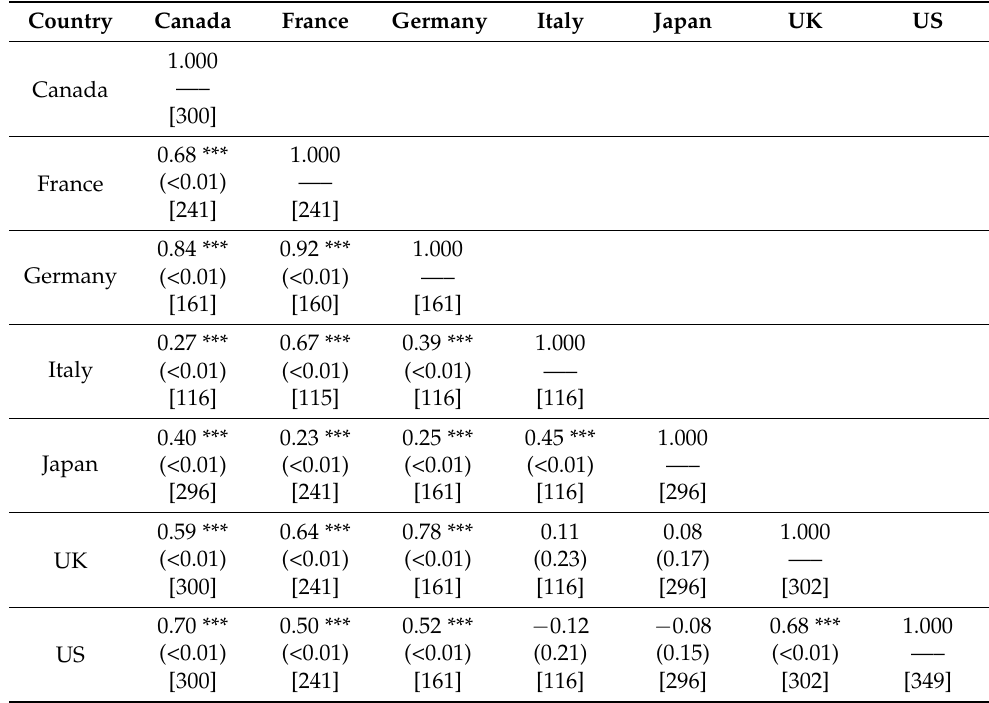
Table 1. Correlation matrix: